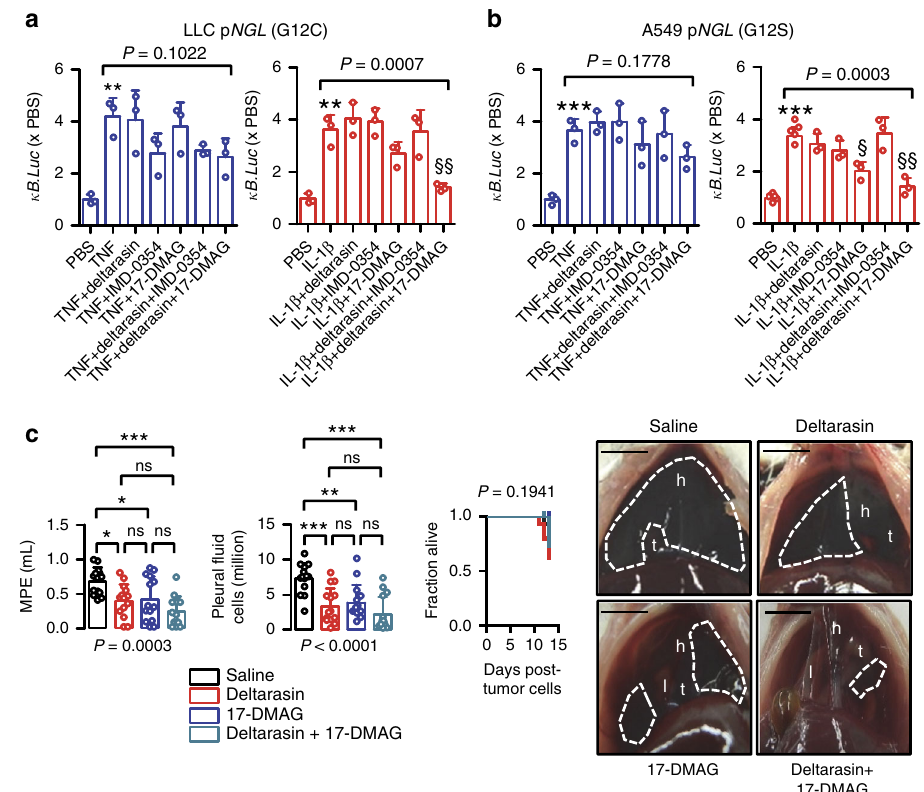
Fig. 9 Combined targeting of mutant KRAS and IKK α abolishes IL-1 β -induced NF- κΒ activation and malignant pleural effusion development. a , b Bioluminescent detection of NF- κΒ reporter activity in LLC ( a ; C57BL/6 Lewis lung carcinoma, Kras G12C ) and A549 ( b ; human lung adenocarcinoma, Kras G12S ) cells stably expressing p NGL under PBS or 1 nM TNF- or IL-1 β -stimulated conditions (4 h), with or without pretreatment with 1 μ M deltarasin, IMD-0354, or 17-DMAG alone or in combination ( n = 3 independent experiments). Note four-fold induction of NF- κΒ reporter activity by both TNF and IL- 1 β . Note also inability of any treatment to block TNF-induced NF- κΒ activation and of any standalone treatment except 17-DMAG to inhibit IL-1 β -induced NF- κΒ activation. Finally, note complete abrogation of IL-1 β -induced NF- κΒ activation in both cell lines by deltarasin/17-DMAG combination. Data are presented as mean ± s.d. P , probability of no difference by one-way ANOVA (PBS group excluded). Double and triple asterisks (** and ***): P < 0.01 and P < 0.001, respectively, for comparison with PBS by Student ’ s t -tests. Single and double section symbols (§ and §§): P < 0.05 and P < 0.01, respectively, for comparison with TNF or IL-1 β by Bonferroni post-tests. c Malignant pleural disease induced by LLC cells in wild-type C57BL/6 mice treated with deltarasin and/or 17-DMAG. Mice received pleural LLC cells, were allowed 5 days for pleural tumor development, and were randomized to daily intraperitoneal treatments with saline (100 μ L), deltarasin, 17-DMAG, or both (both at 15 mg/Kg in 100 μ L saline; n is given in Supplementary Table 3). Shown are data summaries of effusion volume and pleural fl uid cells and Kaplan – Meier survival plot, as well as representative images of effusions (dashed lines), pleural tumors (t), lungs (l), and hearts (h). Data are presented as mean ± s.d. P , probability of no difference by one-way ANOVA or log-rank test. ns, single, double, and triple (*, **, and ***): P > 0.05, P < 0.05, P < 0.01, and P < 0.001, respectively, for the indicated comparisons by Bonferroni post-tests. Scale bars, 1